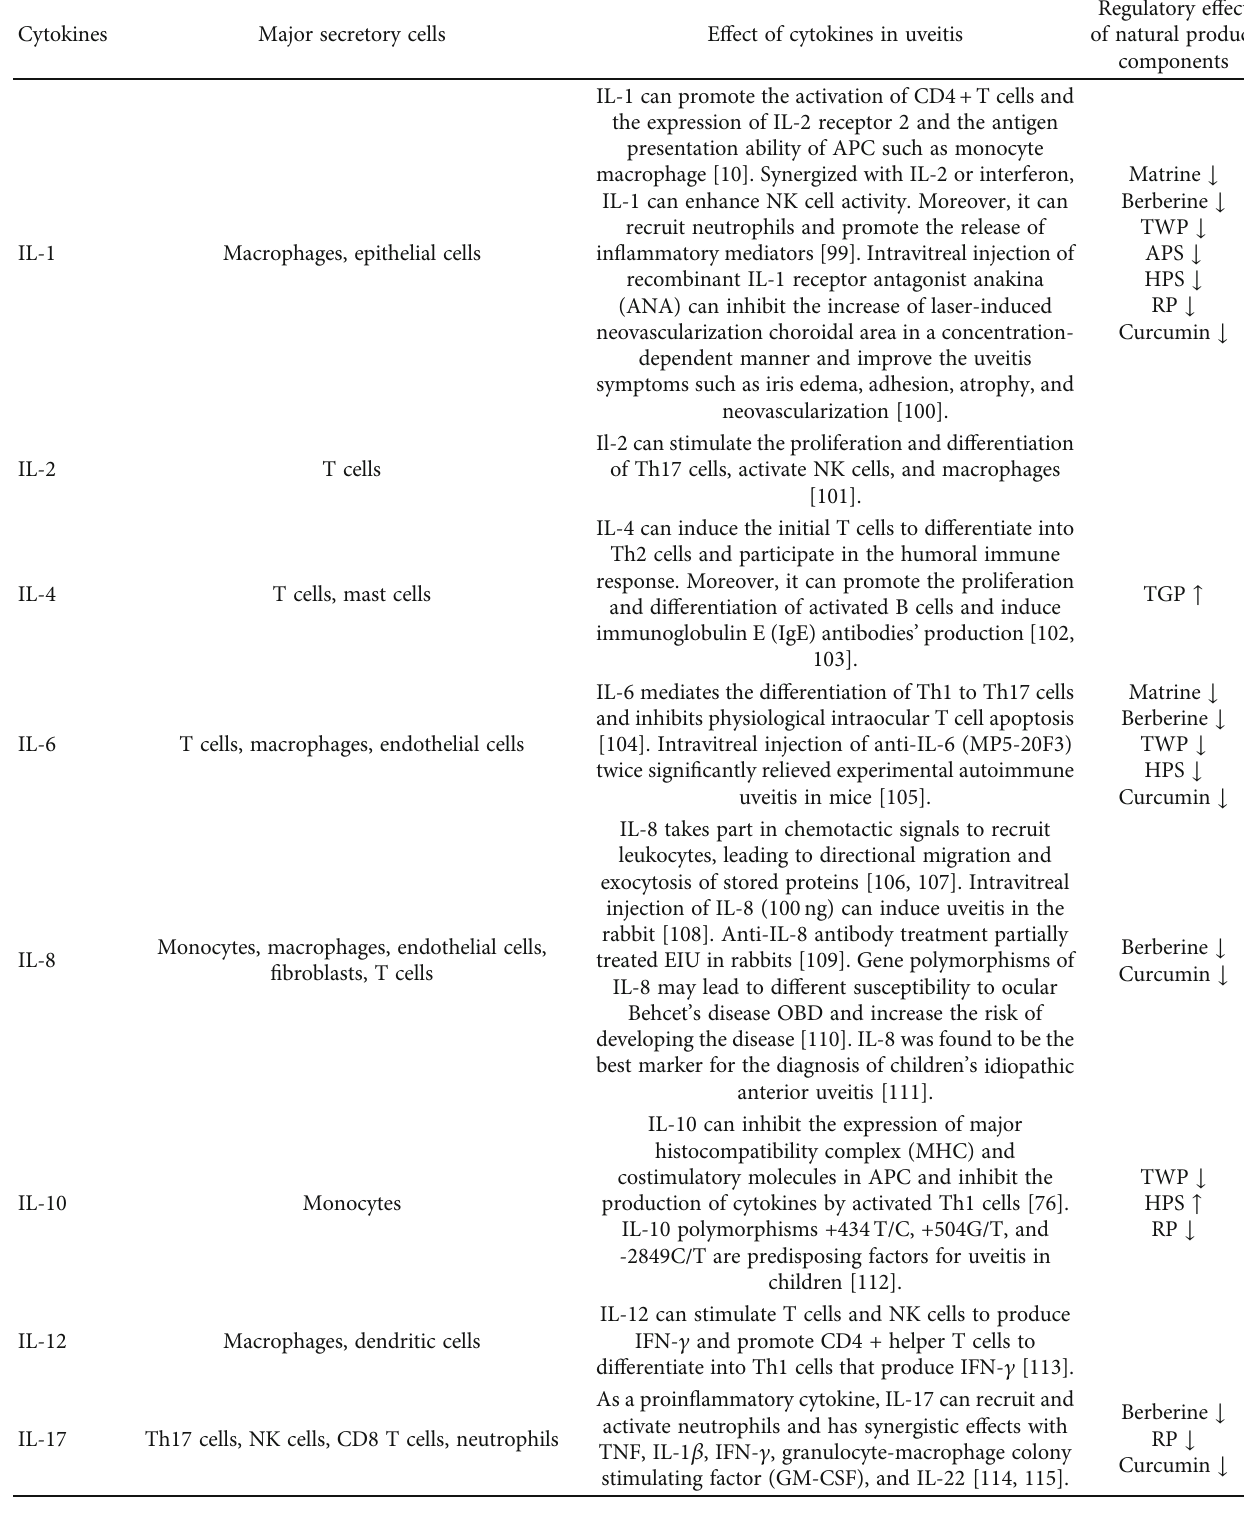
Table 4: Regulatory e ff ect of natural products on cytokines in